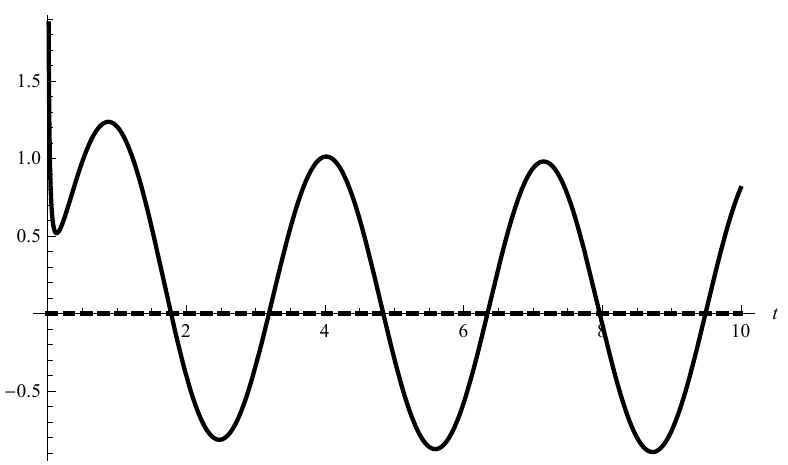
Figure 1. Example 2: Graph of the function G ( t )